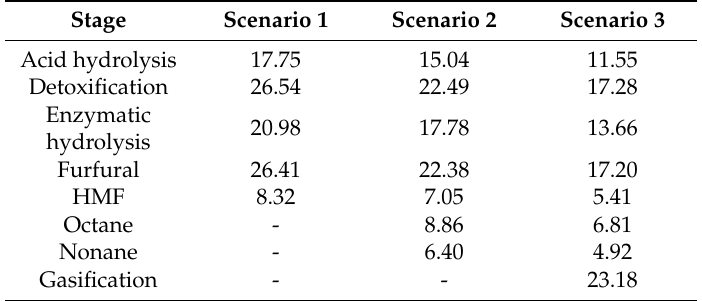
Table 3. Exergy efficiency by stage in each